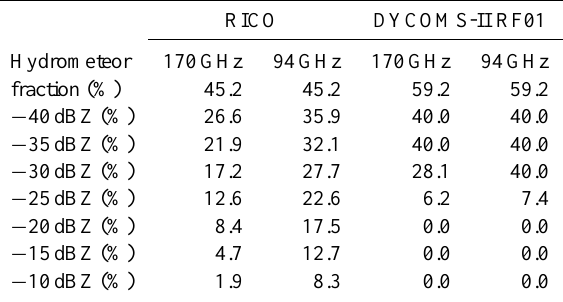
Table 4. The fraction of boundary layer range bins detected at 170GHz and 94GHz for minimum detectable signals ranging from − 40 to − 10dBZ. Also shown is the fraction of range bins contain- ing hydrometers. This analysis is performed after convolution with the assumed antenna gain